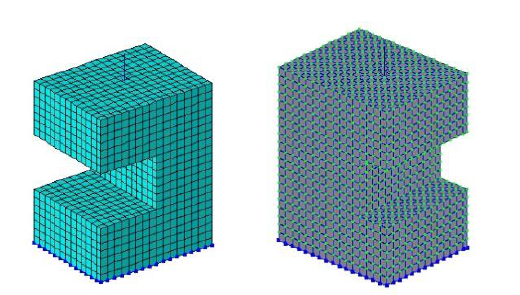
Figure 6. Finite Element Model of a Damaged